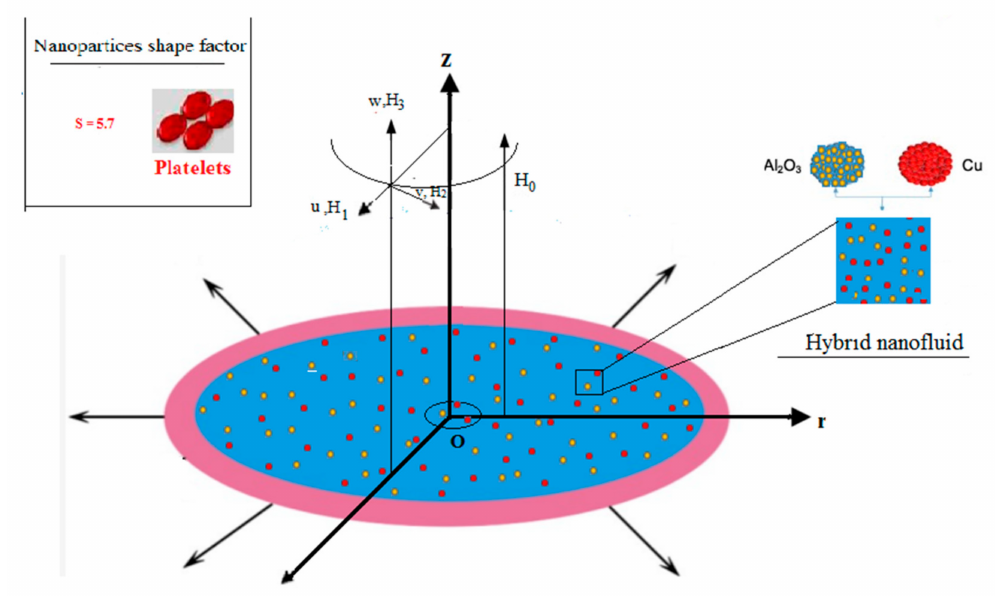
Figure 2. Schematic representation.